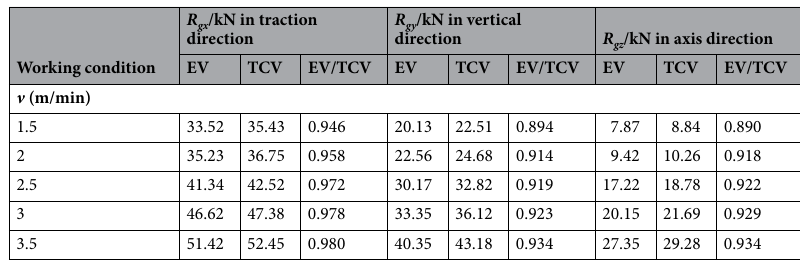
Table 4. Experimental values (EV) and traditional calculated values (TCV) of the drum.